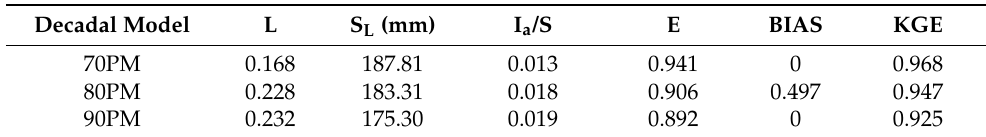
Table 1. The optimum S (S L ), L, I a to S ratio, Nash–Sutcliffe index, bias, and KGE index for each decadal dataset in Peninsular Malaysia.